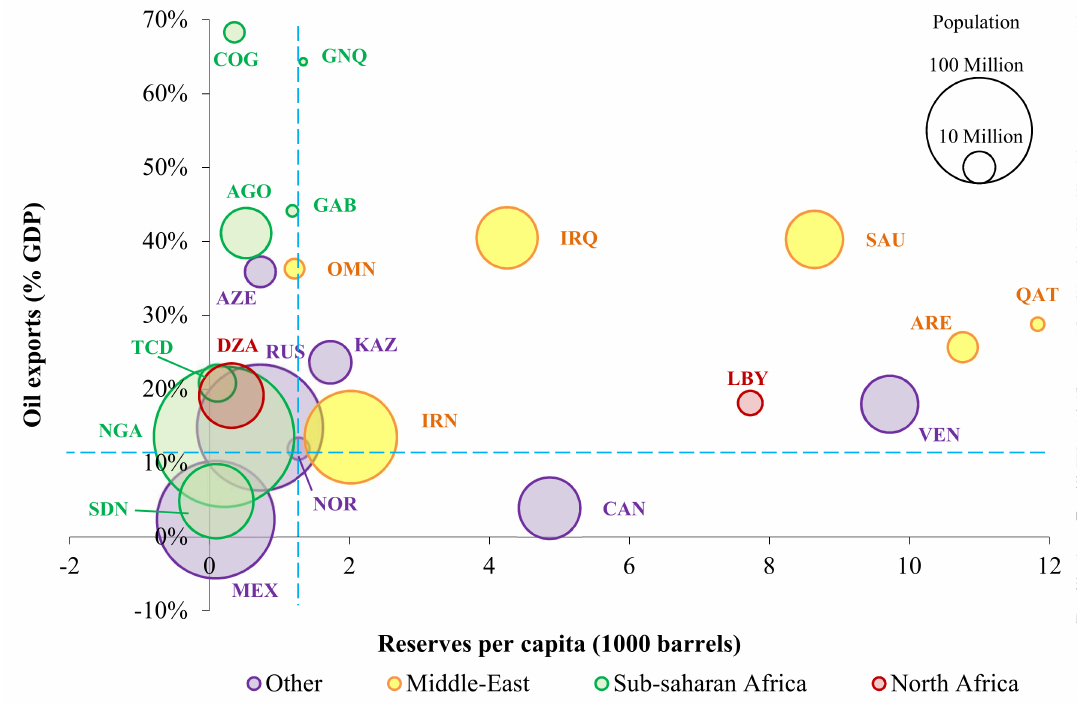
Figure 5. Exposure of economy: oil exports vs. GDP (2014). Note: The blue dotted lines are centered on Norway (NOR). Data: [19,21,25]. Kuwait (KWT) is not shown because it has very high reserves per capita (27,000 bl, oil exports ~60% GDP).